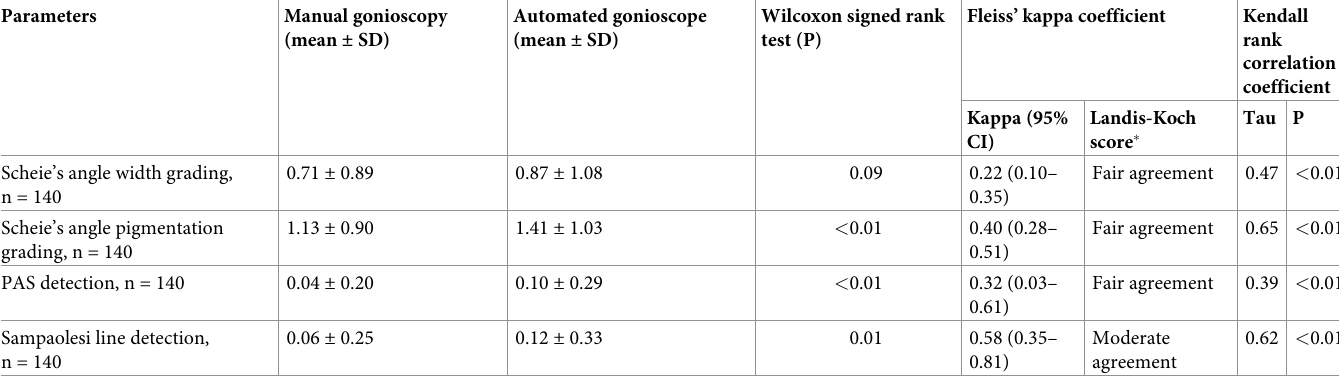
PAS = peripheral anterior synechia; SD = standard deviation; CI = confidence interval. � The Landis-Koch score is used to interpret the kappa